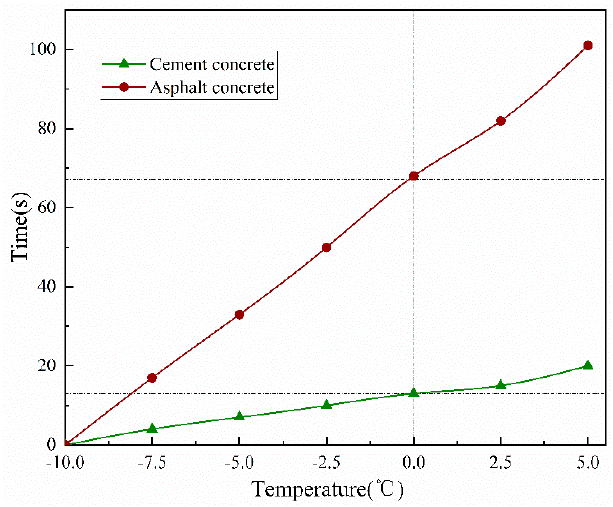
Figure 12. Temperature variation of concrete G points of different pavement materials at 5.8 GHz frequency.